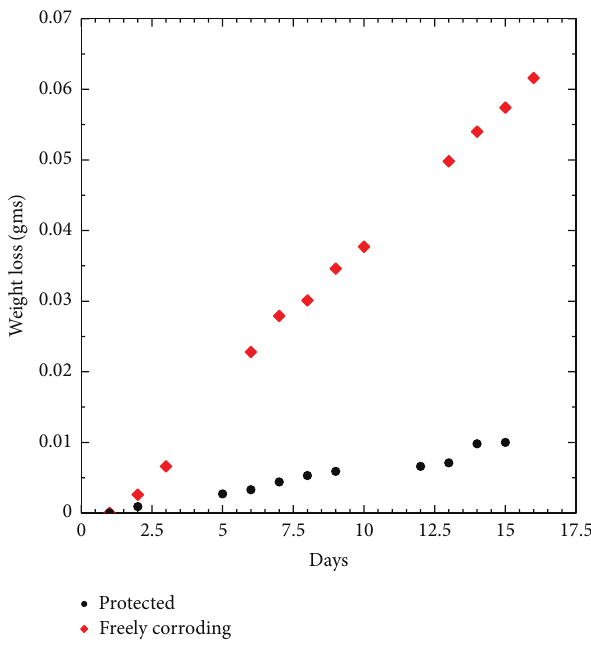
Figure 7: The weight loss of the freely corroding and the ACPS protected A36 steel samples in the 0.6 M NaCl solution for 15 days. Two A36 samples, one corrosion protected using the proposed system and the other freely corroding, are shown. The freely corroding sample lost 0.0616 gm weight and the protected sample lost only 0.01gm